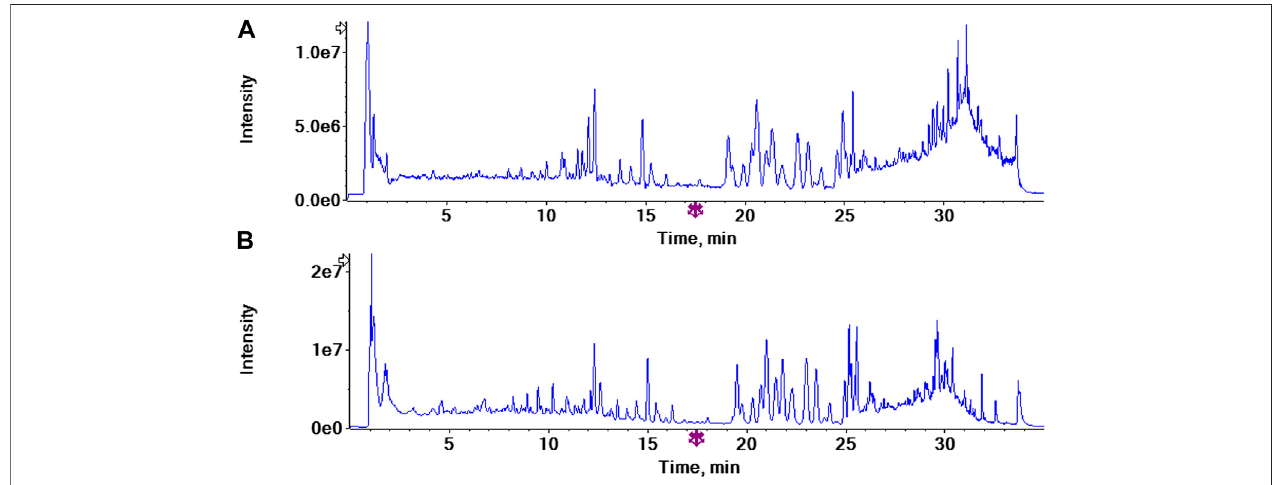
FIGURE 2 | The total ion chromatograms (TICs) of Platycodon grandi fl orum by UPLC/Q-TOF-MS/MS (A) TIC of Platycodon grandi fl orum in positive ion mode (B) TIC of Platycodon grandi fl orum in negative ion mode.